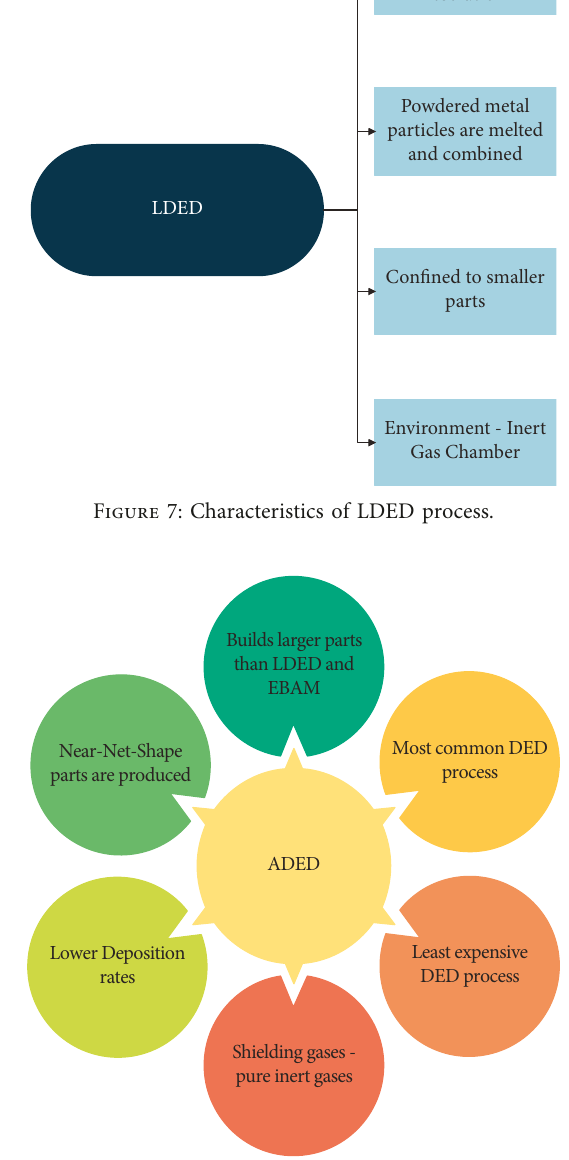
Figure 8: Characteristics of an ADED